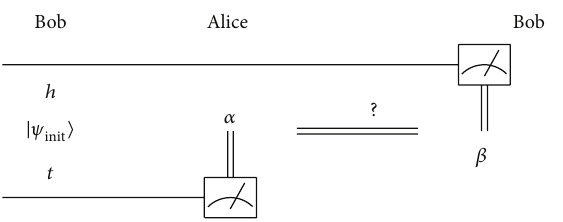
Figure 2: The schematic diagram of a control mode in the ping- pong protocol.